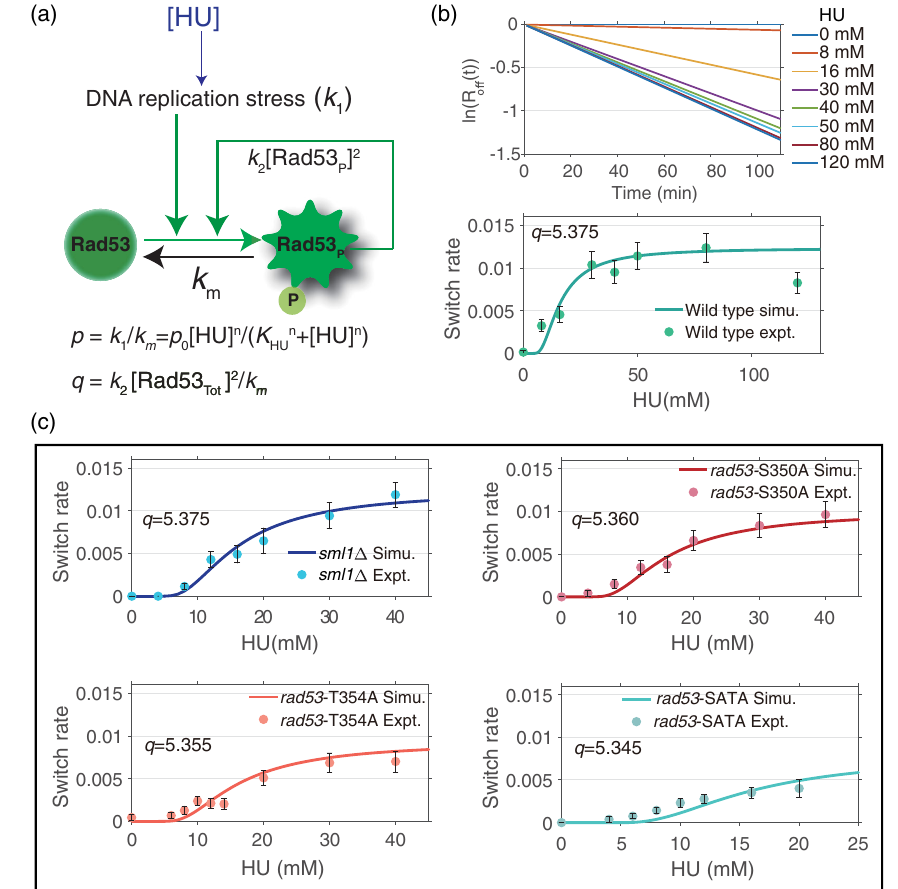
FIG. 4. Quantitative modeling for the activation process of the S-phase checkpoint (ASPC) in budding yeast and switching rate from off to on states induced by HU stress. (a) Schematic demonstration of the mathematical model. The model incorporates two dimensionless parameters, p and q , where p represents the effect of DNA replication stress induced by HU concentration, and q depicts the intensity of autophosphorylation of Rad53 molecules (Table I). (b) Top panel: Quantitative results of the exponentially distributed off-to-on switching time produced by the stochastic model. Bottom panel: Switching rates from off to on states of ASPC calculated by the stochastic model for different HU concentrations (relevant to parameter p ) in WT strains, which agree very well with the experimentally measured switching rates. (c) Switching rates for different Rad53 mutation strains (relevant to parameter q ). The error bars denote the standard deviation of the experimental switching rates (see Sec. II of the Supplemental Material [45]). The fitted 10 4 min − 1 , N ¼ 1000 , K 2 mM, n ¼ 2 , p 4 . 38 × 10 − 2 , q 5 . 375 , q 5 . 375 , parameters in the model are k 0 ¼ m ¼ sml 1 Δ ¼ HU ¼ WT ¼ 5 . 360 , q 5 . 355 , and q 5 . 345 q TA ¼ SA ¼ SATA ¼ intensity parameter q in the mutant strain model ( q ¼ 5 . 360 in rad 53 -S 350 A, q ¼ 5 . 355 in rad 53 -T 354 A, q ¼ 5 . 345 in rad 53 -SATA) differed from the setting of the WT and sml 1 Δ strain models ( q ¼ 5 . 375 in both strain models).